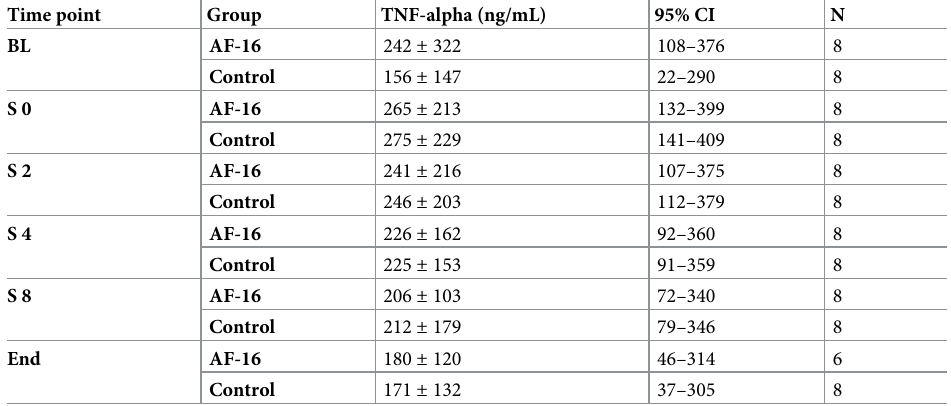
Table 6. TNF-alpha concentration.